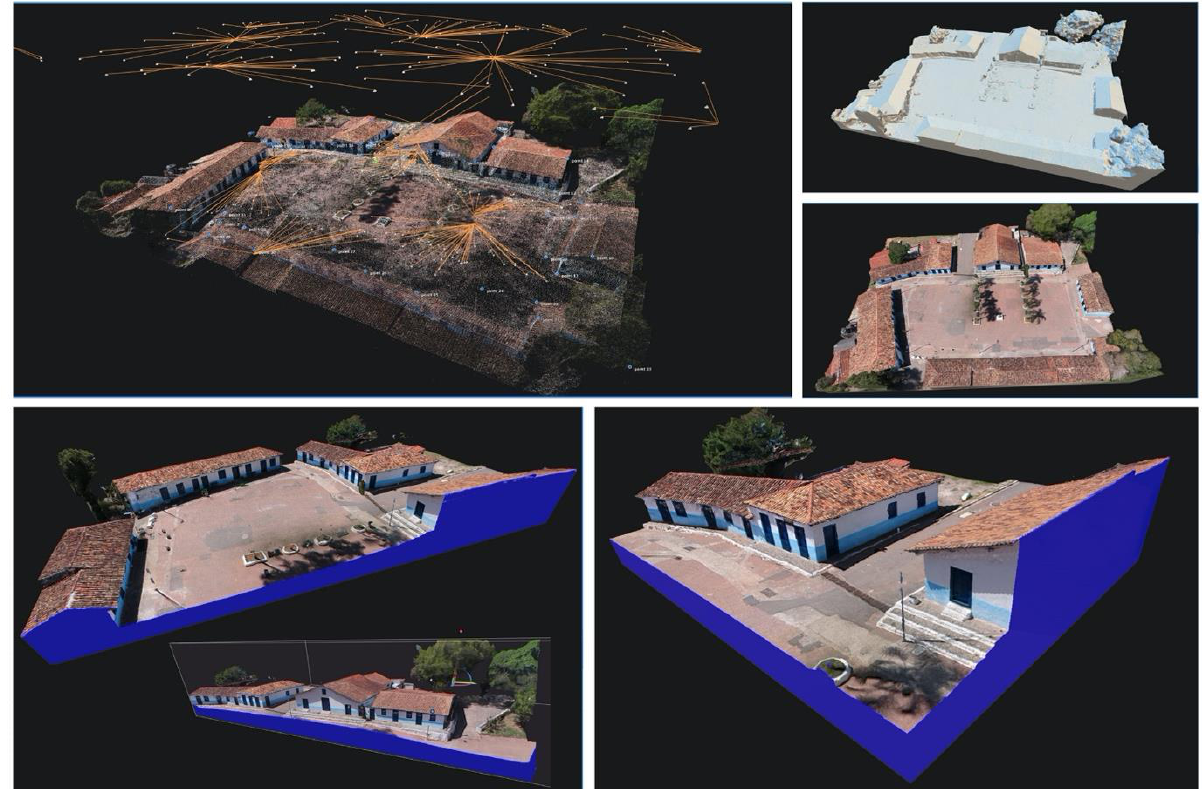
Figure 6. Views of the images processing, of the model and texture reconstruction, and of the extractions of section from the 3Dmodel, obtained with the Software ©Reality